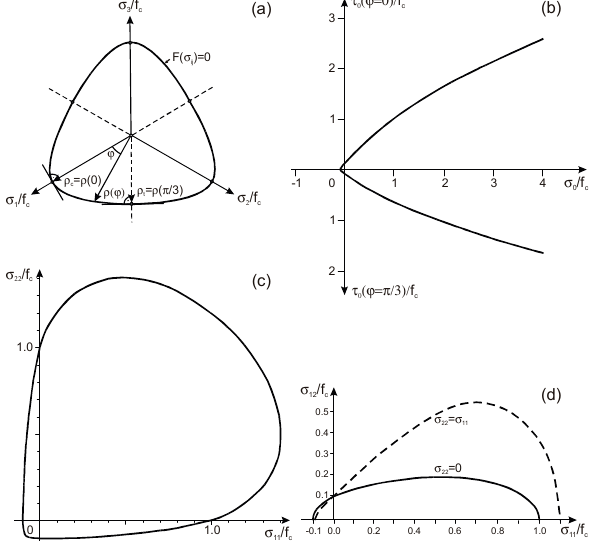
Figure 1. Limit surface for K = 1, ϕ t = 0.1, ϕ cc = 1.1: ( a ) section through the octahedral plane; ( b ) section through the Rendulic plane; compression curve for ϕ = 0, tension curve for ϕ = (cid:3095) stress state; ( d ) reduced plane stress state.